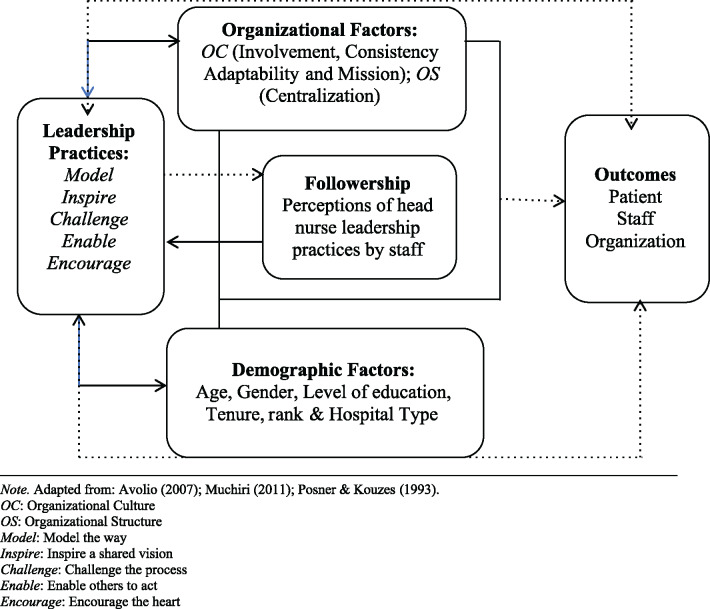
Integrated model of [nursing] leadership. Adapted from: Avolio (2007), Muchiri (2011) and Posner and Kouzes (1993). OC, organizational culture; OS, organizational structure; Model, model the way; Inspire, inspire a shared vision; Challenge, challenge the process; Enable, enable others to act; Encourage, encourage the heart